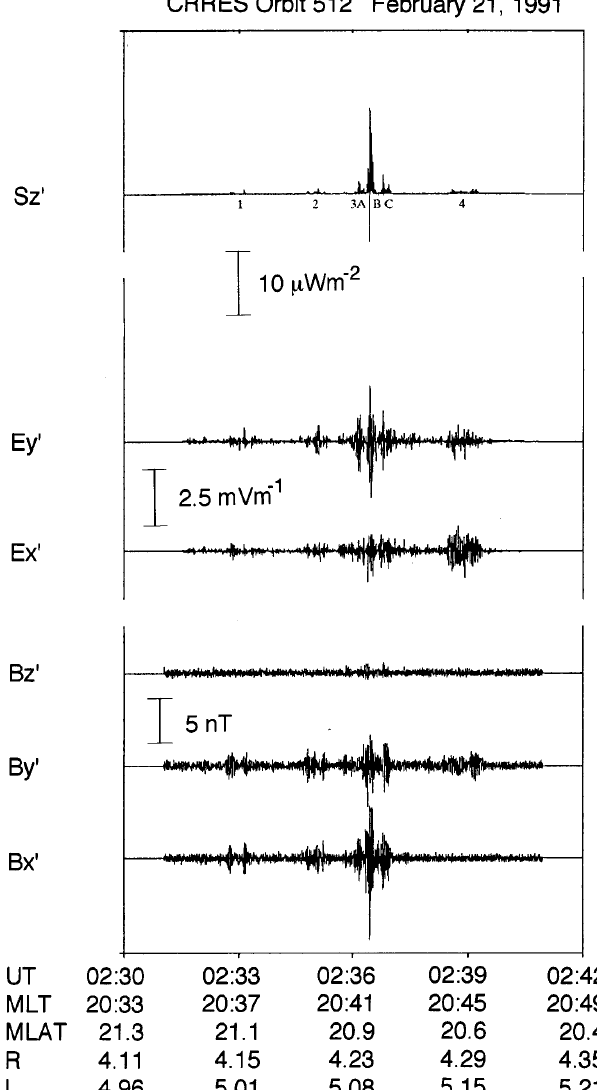
Fig. 16. Poynting flux ( S 0 ), electric field ( E 0 z ( B 0 ; B 0 ; B 0 ) for a series of Pc 1 waves observed by the CRRES satellite X y z in the plasmasphere (reproduction of Fig. 1 of Fraser et al ., 1996). The positive sign of S 0 means energy propagation away from the z equator